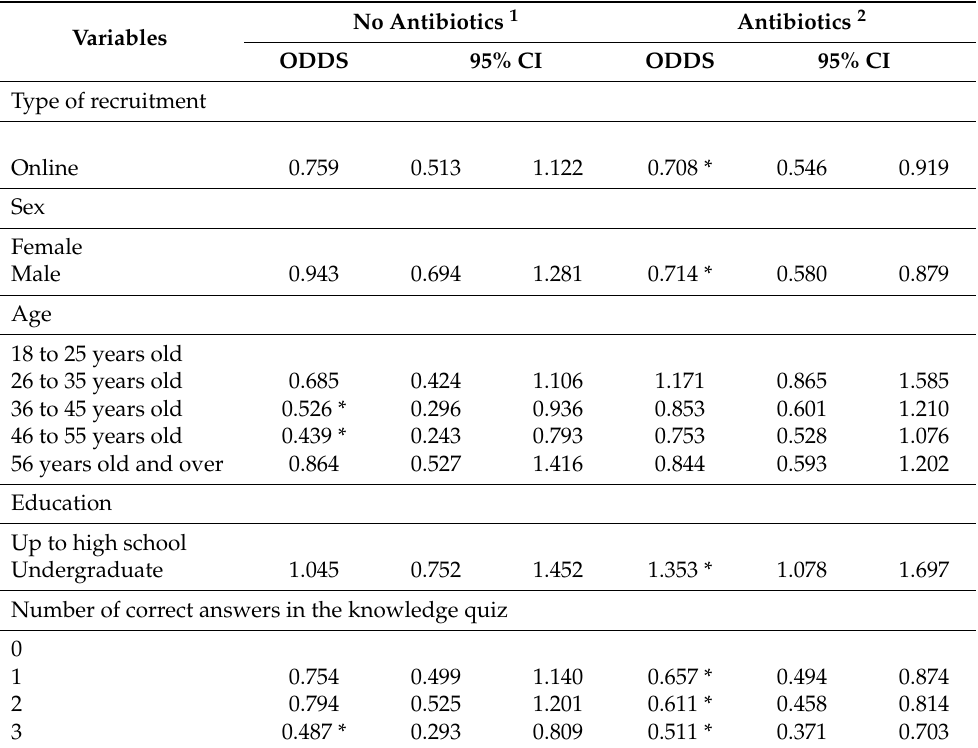
Table 2. Odds ratio (ODDS) and 95% confidence interval (95% CI) for multinomial logistic regression models of opinion towards the most appropriate solution for unhealthy pigs on the farm (Q1). Reference category was: “At the time of diarrhea or respiratory infection diagnosis, euthanize pigs on the farm to avoid spreading the disease to healthy